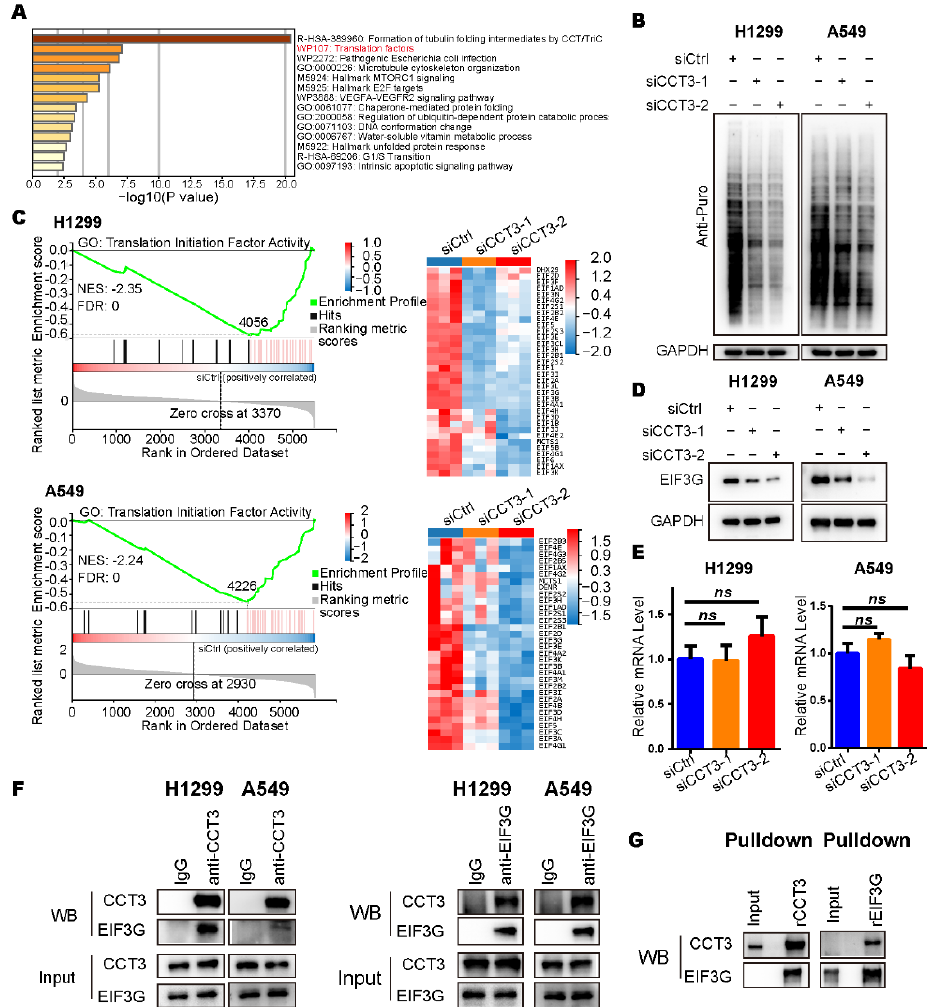
Figure 5. The global translation was reduced in CCT3-knockdown LUAD cells. ( A ) Pathway enrich- ment analysis of down-regulated proteins in CCT3-knockdown LUAD cells analyzed with Metascape. ( B ) Representative WB images of SUnSET assays in H1299 and A549 cells with the indicated treatments. Note: 10 μ g/mL puromycin was added into the culture medium to label the newly synthesized peptides in cells. ( C ) GSEA enrichment plots ( left ) of the translation initiation factor activity pathway, and heat maps ( right ) of the corresponding down-regulated proteins in indicated groups. The red represents overexpression, and the blue symbolizes down-regulation. ( D ) Repre- sentative images of WB showing that EIF3G was decreased in CCT3 knockdown cells. ( E ) Relative mRNA levels of EIF3G in H1299 and A549 cells treated with siRNAs targeting CCT3 or a control. The values were normalized to the mRNA level of GAPDH. Three independent experiments were performed. Data are shown as mean + SD; ns, not significant, two-tailed Student’s t -test. ( F ) Repre- sentative WB images of the interaction between CCT3 and EIF3G detected by co-IP assays. ( G ) The physical interaction between CCT3 and EIF3G was validated by pull-down assays.